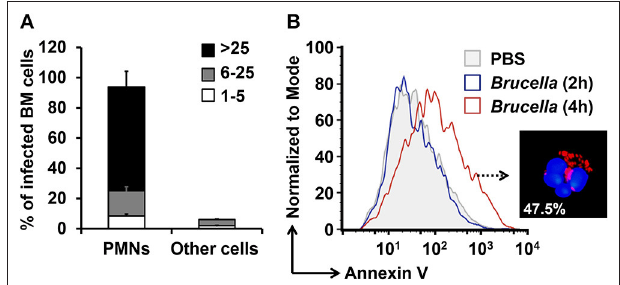
FIGURE 1 | B. abortus infect PMNs and promote the exposure of phosphatidylserine. BM cells were incubated with B. abortus -RFP (MOI 50) for 4h. (A) Cells were mounted using Prolong Gold containing DAPI (blue nuclei). At least 200 PMNs were counted per sample. The percentage of infection and the number of intracellular bacteria (1–5, 6–25, or > 25) per cell was determined by fluorescence microscopy. Cell infections were confirmed by flow cytometry. (B) The PMN population analyzed by flow cytometry was gated using anti-Ly6G as PMNs cell marker and analyzed by Annexin V as a cell death marker. These experiments were repeated at least three